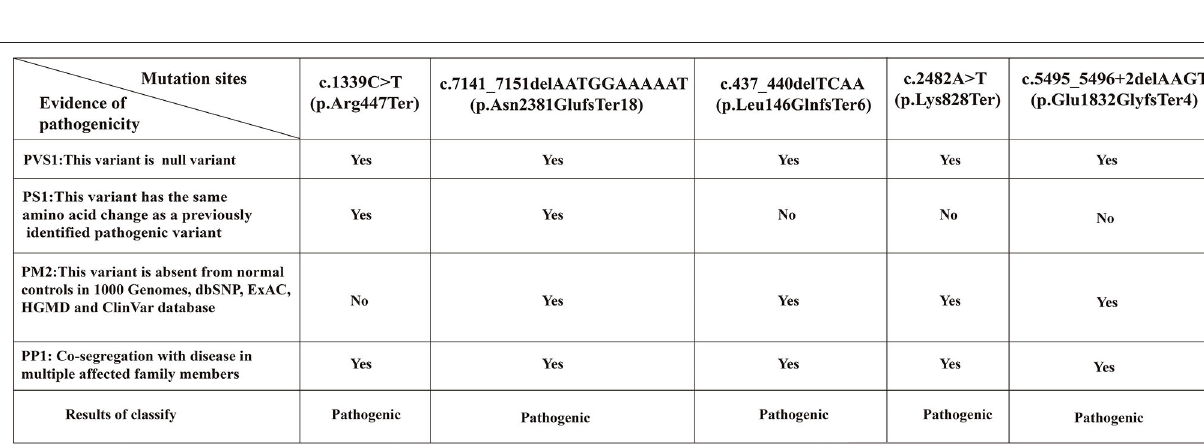
FIGURE 7 | Diagram of the domain structure of ATM protein. ATM protein contains four domains, which are the TAN domain (amino acids 8–165; shown in the dark blue area), FAT domain (amino acids 2,097–2,489; shown in the green area), PIKKc domain (amino acids 2,683–2,962; shown in the red area), and FATC domain (amino acids 3,026–3,055; shown in the purple area; https://www.ncbi.nlm.nih.gov/Structure/cdd/wrpsb.cgi?INPUT_TYPE=live&SEQUENCE=NP_000042.3). ATM protein also contains multiple important autophosphorylation sites, such as S367, S1893, S1981, and S2996 (shown in the orange area). ATM is often activated through the autophosphorylation pathway to perform biological functions. The yellow triangles indicate the positions of amino acids synthesis termination corresponding to the ATM mutation sites identified in our patients, showing that the domains of ATM protein are damaged.